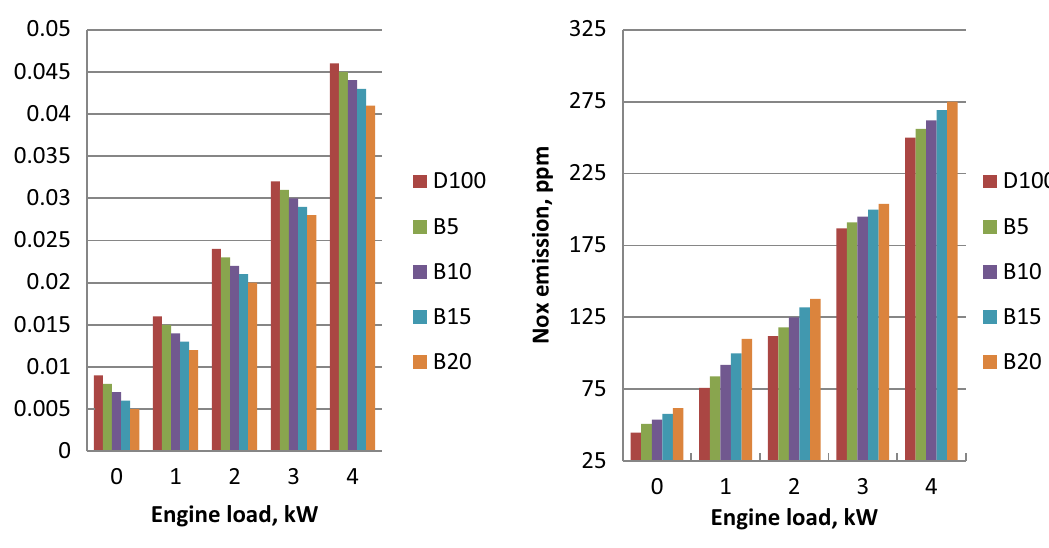
Figure 5. CO and NO x emissions with engine load for biodiesel